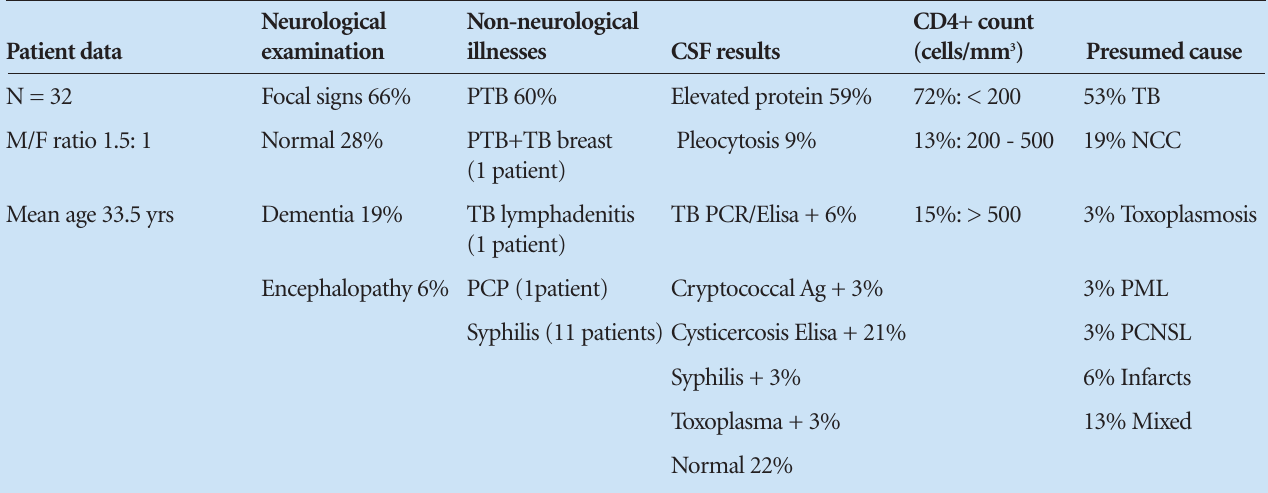
Table I.Focal brain lesions (FBLs) – clinical and laboratory findings with presumed cause/s